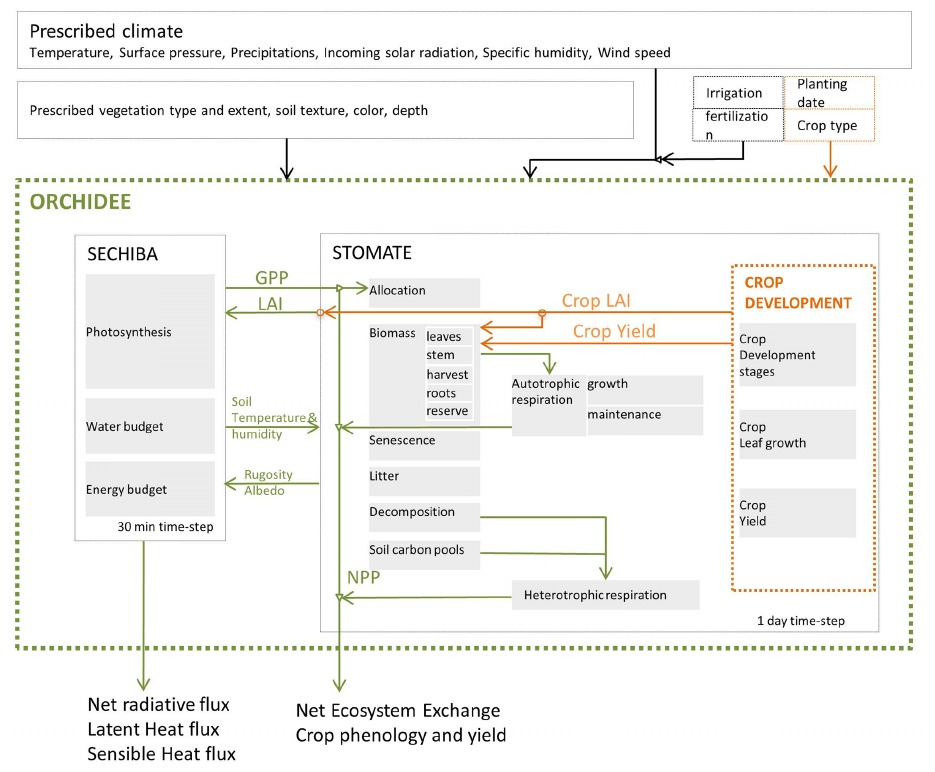
Figure 1. Model structures of the ORCHIDEE-CROP. The crop development module (based mainly on STICS; Brisson et al., 1998) is integrated into the STOMATE module of ORCHIDEE (Krinner et al., 2005). The crop development module simulated the phenology, devel- opments, and grain yields for crop PFTs. ORCHIDEE-CROP consists in the coupling of two modules. SECHIBA simulates the vegetation photosynthesis, water, and energy budgets; STOMATE is a carbon module and calculates carbon allocation in different carbon pools and fluxes to the atmosphere. This figure is adapted from Valade et al.